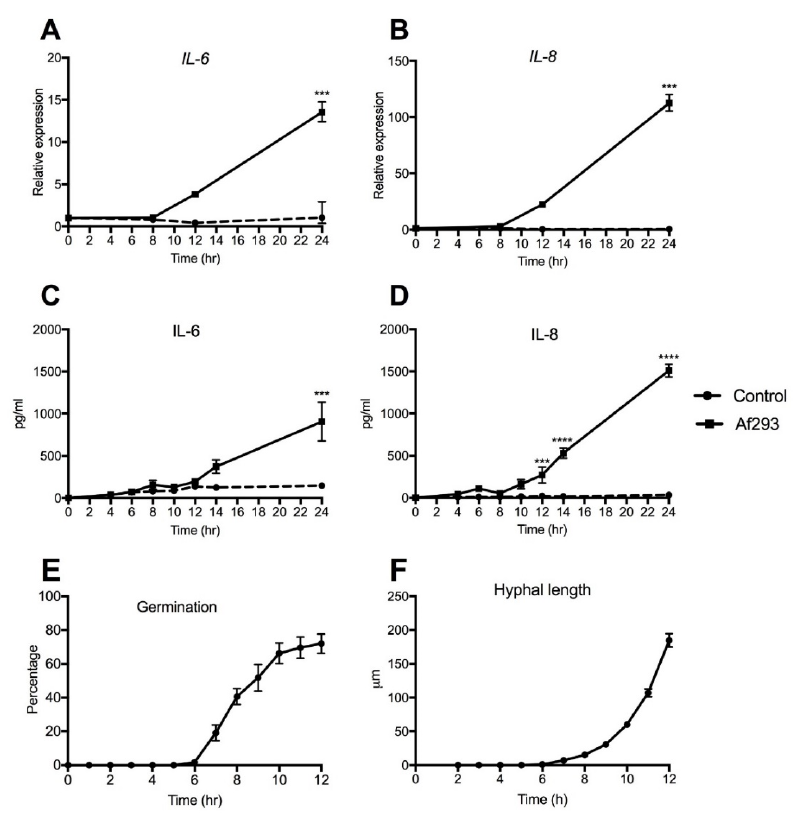
Figure 2. A fumigatus -induced cytokine secretion coincides with the onset of conidial germination. A. fumigatus significantly upregulated both ( A ) IL-6 and ( B ) IL-8 gene expression compared with unexposed control cells. ( C ) IL-6 protein level was significantly increased at 24 h, whereas ( D ) IL-8 reached significance at 12 h and 24 h compared with control. ( E ) Percentage germination and ( F ) hyphal growth of GFP-expressing conidia co-cultured with 16HBE14o- cells showed germination after 6 h, with a rapid increase between 6 and 10 h. Data represent mean +/ − SEM; two-way ANOVA with Bonferroni multiple comparison test. **** p < 0.0001; *** p < 0.001; compared with the control.